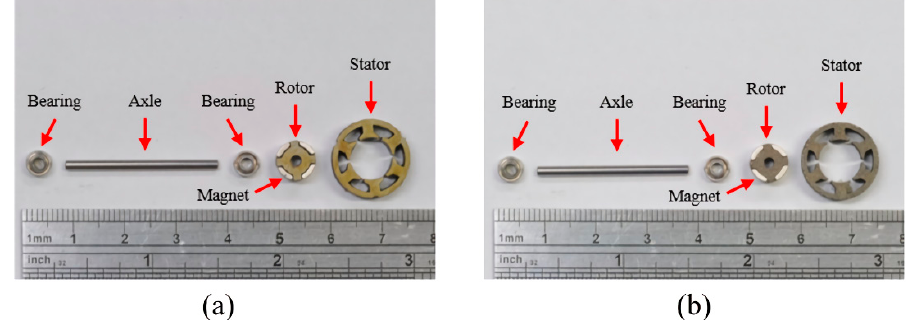
Figure 10. Mechanical parts of ( a ) 35CS300 and ( b ) Somaloy 700 1P motors .